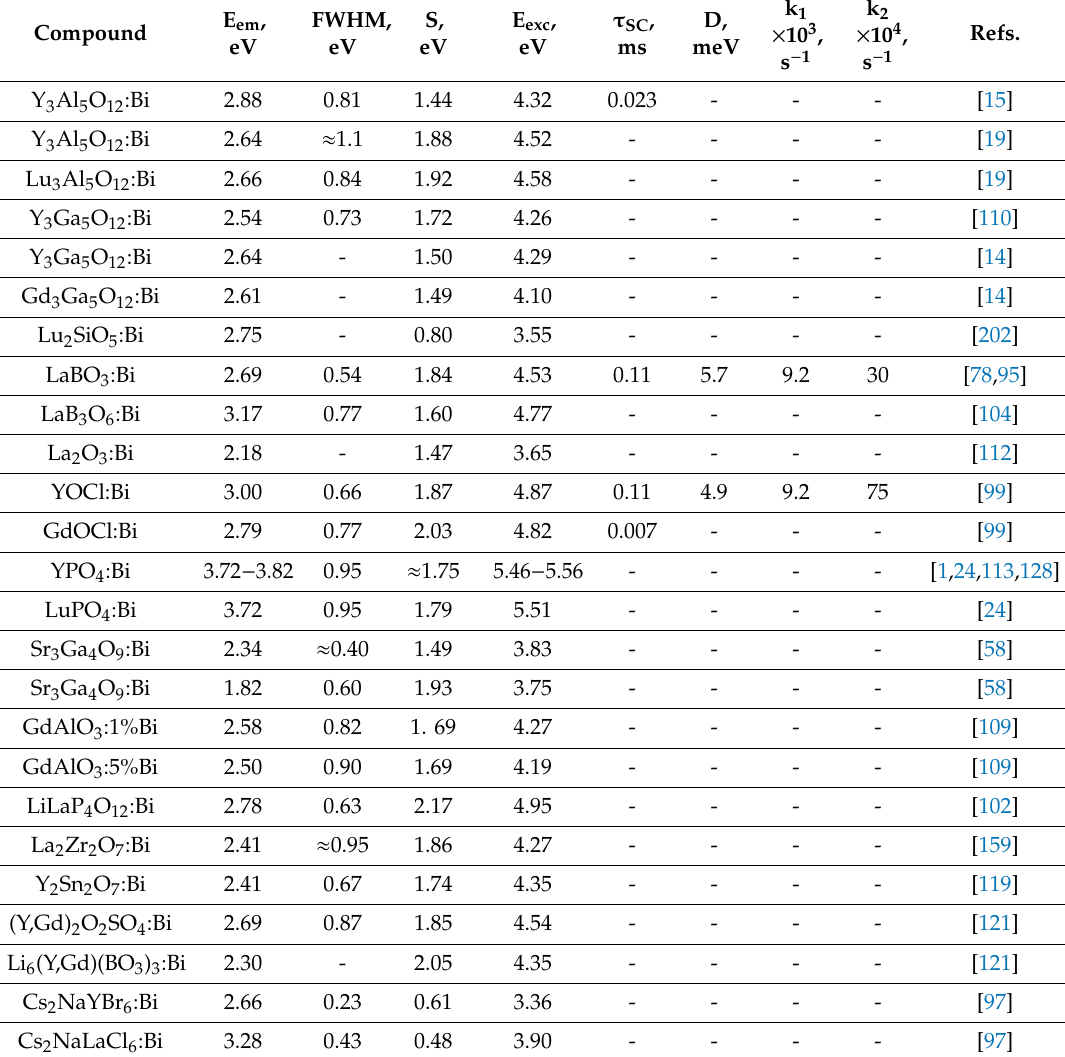
Table 4. Emission peak positions (E em ), full widths at half maxima (FWHM), the Stokes shifts (S), positions of the lowest-energy excitation band (E exc ), and decay times ( τ SC ) of the slow decay component at LHeT obtained for the luminescence ascribed in literature to dimer {Bi 3 + - Bi 3 + } centers. The spin-orbit splitting energy (D) and the probabilities of the radiative decay of the metastable (k 1 ) and emitting (k 2 ) levels of the triplet